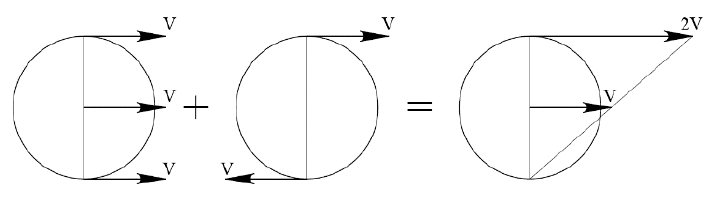
Fig. 7. Diagram of the wheel movement without slipping.